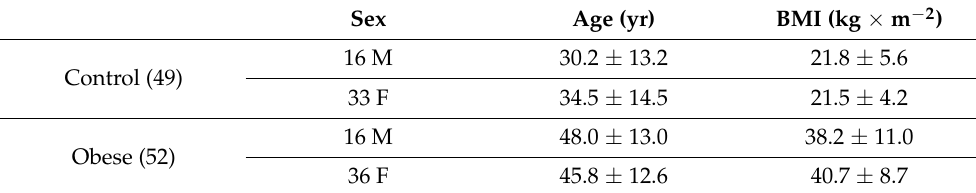
Table 1. Physical characteristics of obese and control subjects (mean ±